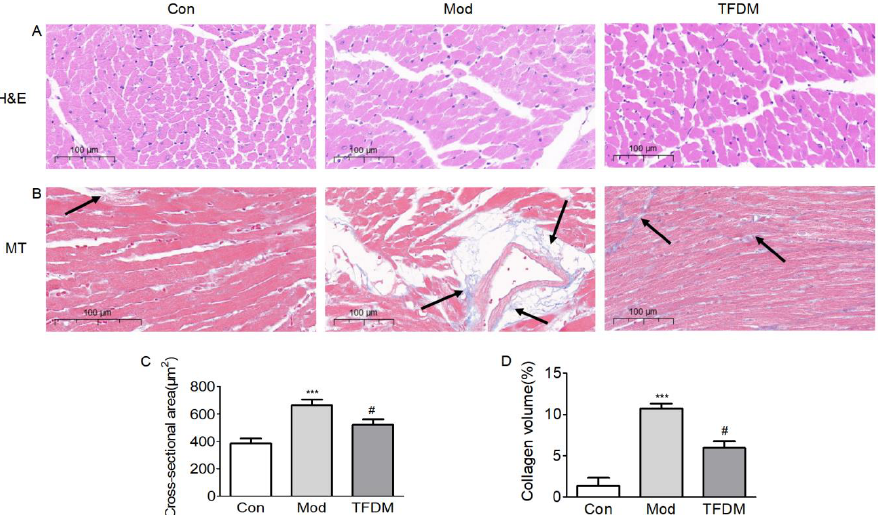
Figure 9. Effects of TFDM on cardiac histology. ( A ) Representative images of hematoxylin and eosin (H&E). ( B ) Representative images of Masson’s Trichrome (MT) staining of transversal sections of the left ventricle of mice. Scale bars: 100 μm. ( C ) The quantification of cardiomyocyte cross-sectional area. ( D ) The quantification of collagen volume. Localisation of collagen fibres demonstrated by black arrow. Three samples in each experimental group and three sections from each individual sample were analyzed by Image J software. Compared with Con group: *** p < 0.001; compared with Mod group # p < 0.05.